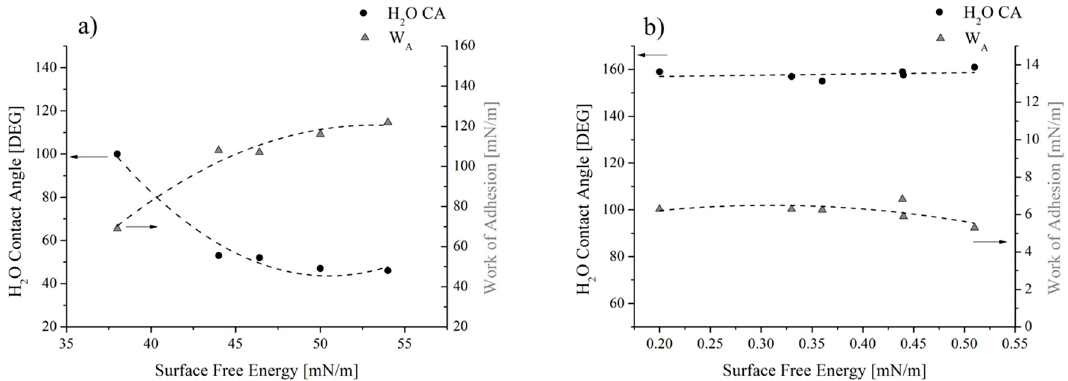
Figure 12. Water contact angle and W A as a function of ( a ) the surface free energy for the reference and ( b ) the coated samples. ( b ) the coated samples.